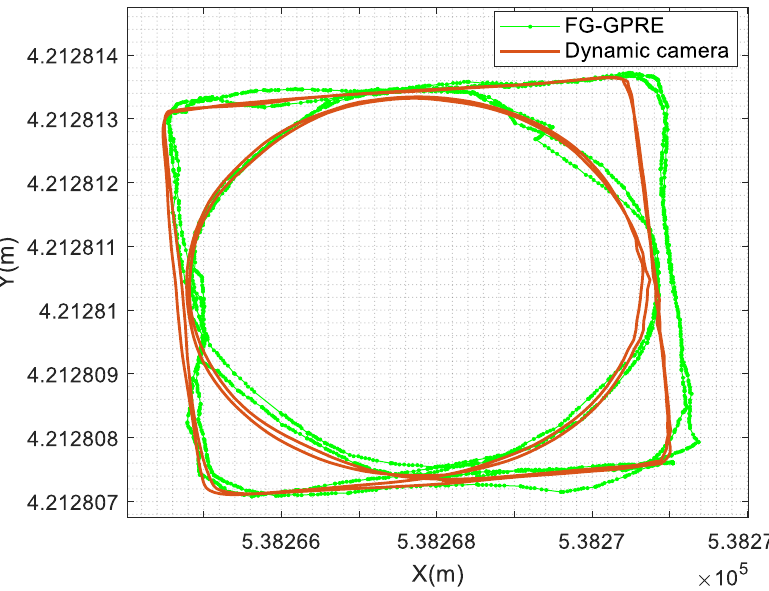
Figure 8. The second group of positioning accuracy comparison test. Table 4. Locate the performance profiling list.